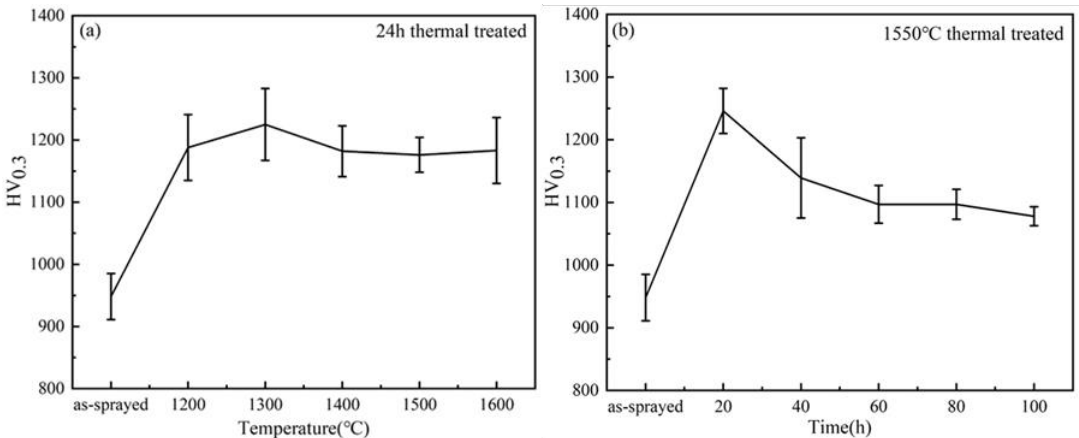
Figure 13. Variation of Vickers hardness of APS YSZ coatings with thermal aging treatment: ( a ) samples after thermal aging treated at different temperatures for 24 h, and ( b ) thermal aging treated at 1550 °C for different times.